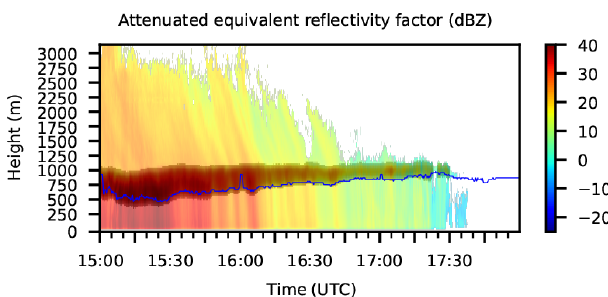
Figure 12. Comparison between the ML height determined by the NN and by a cloud radar for Elmshorn on 22 December 2018 from 15:00 to 18:00UTC. The colors in the background show the ZEA from the MRR, the gray shading denotes the area where the NN detected an ML, and the blue line is the ML detected by a cloud